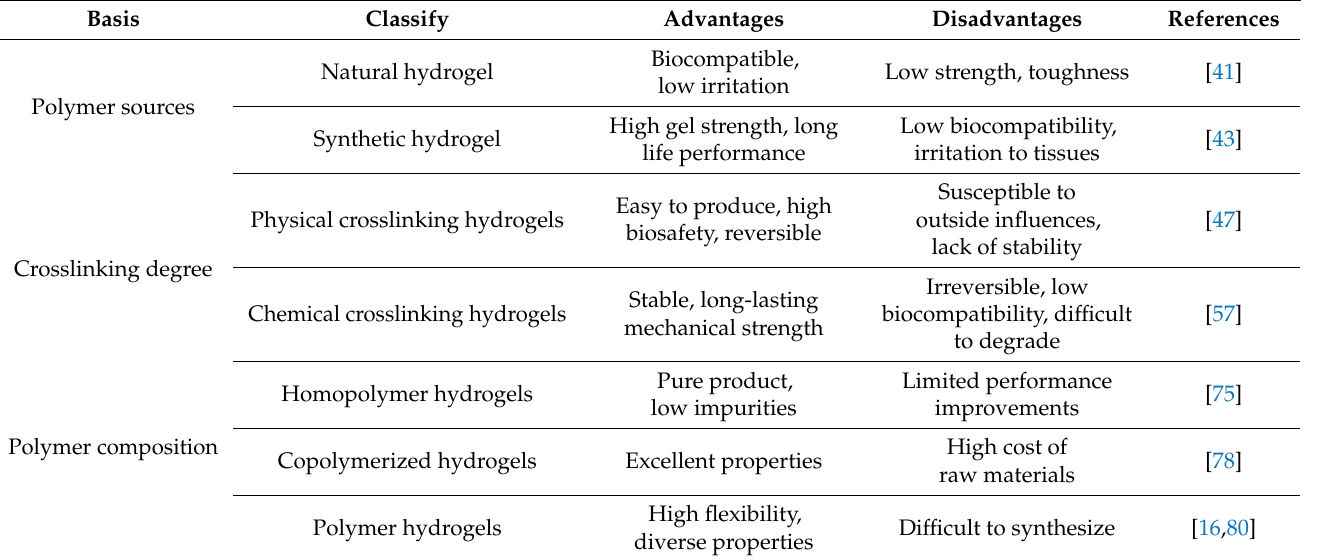
Table 1. Classification and properties of